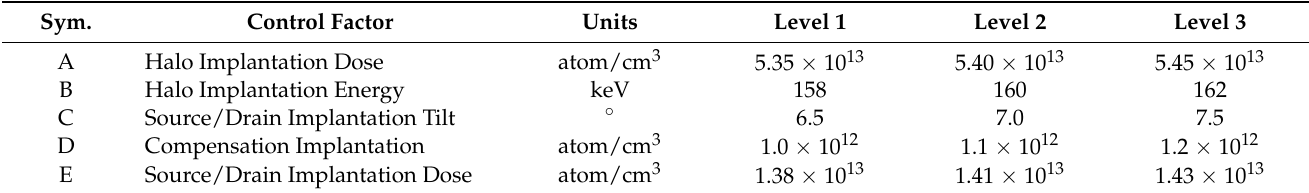
Table 2. Process parameters and their